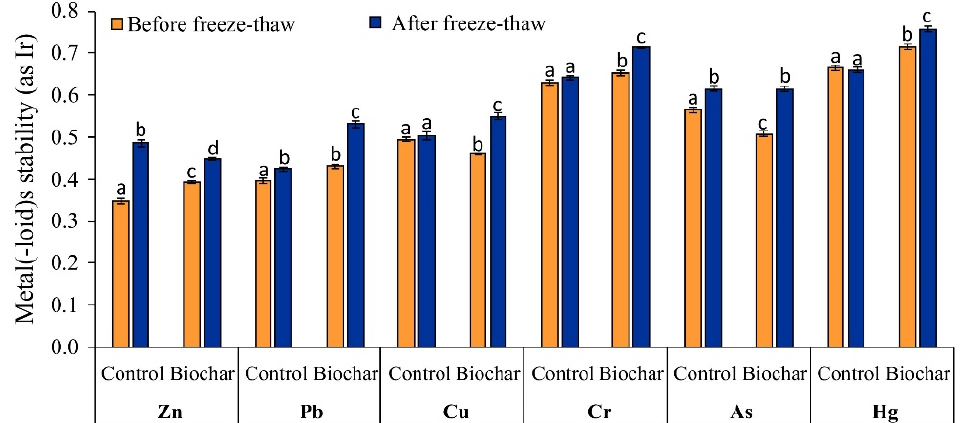
Figure 6. Changes in metal(-loid)s stability (as Ir) in phytostabilized non-amended (control) and biochar-amended soil samples, before and after freeze–thaw. For a given metal(-loid), different letters indicate significant differences in its stability in soil ( p < 0.05).